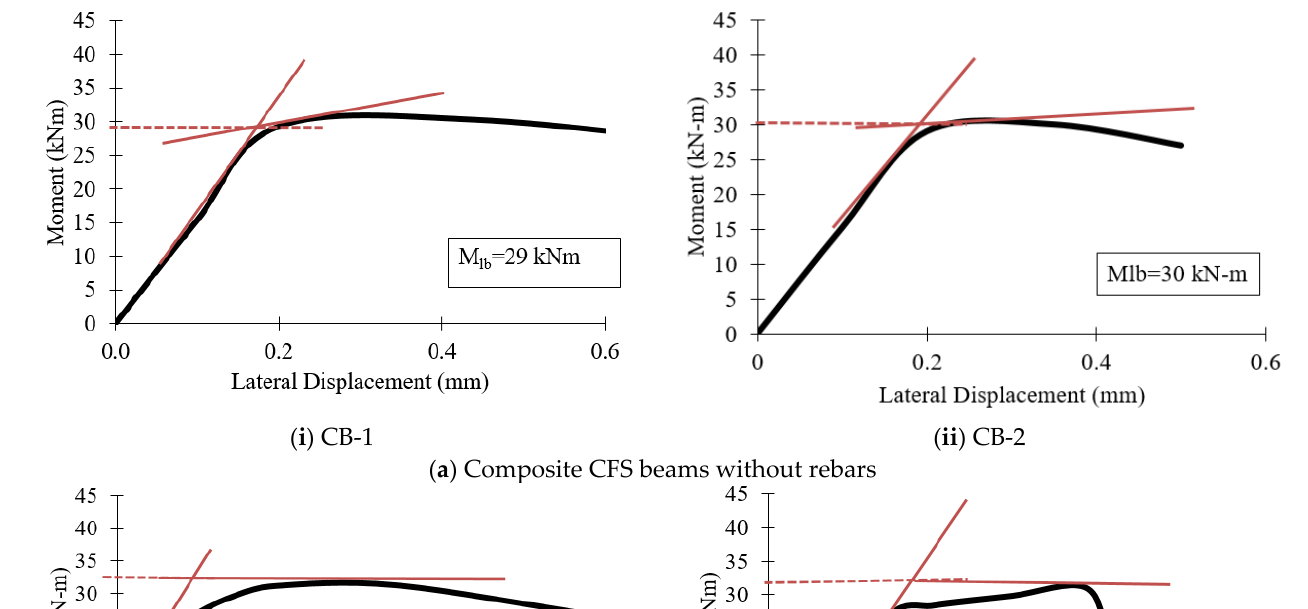
Figure 14. Moment – lateral displacement curves of the plain CFS beams.